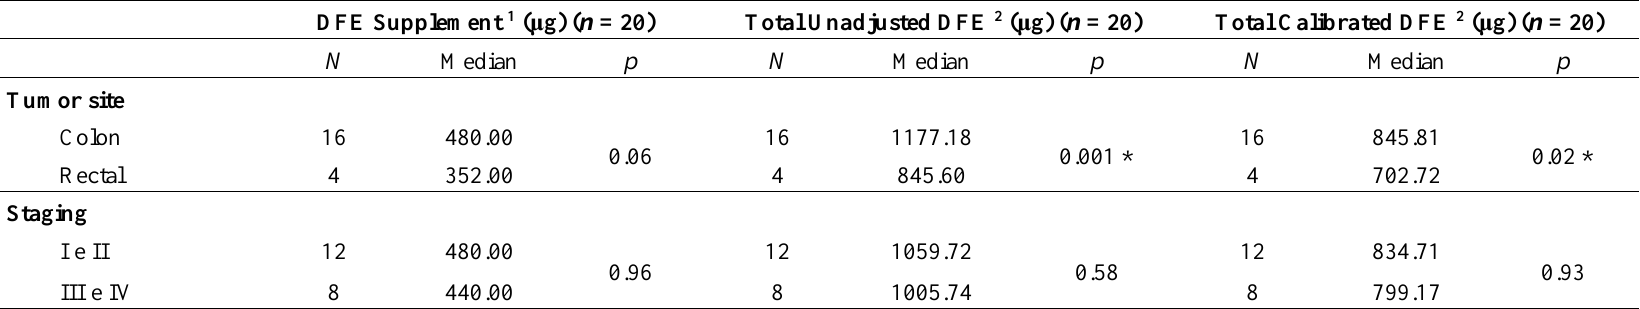
Table 5. Comparison of the medians of supplement, total unadjusted and total calibrated DFE according to clinical characteristics in the pretreatment of patients for colorectal adenocarcinoma.